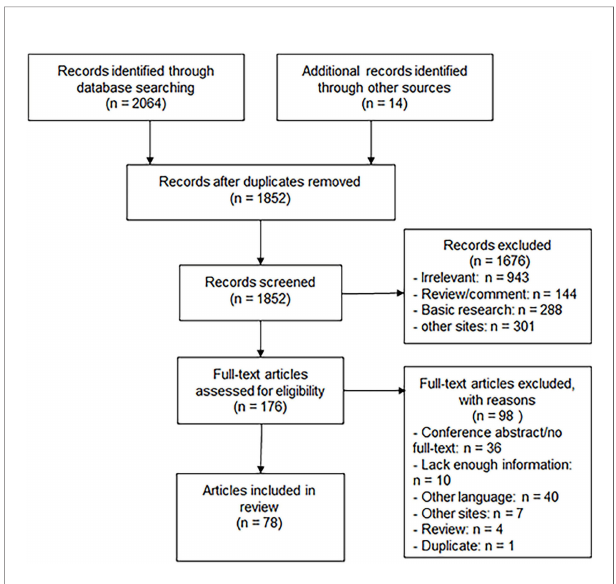
FIGURE 5 | Flowchart of the selection